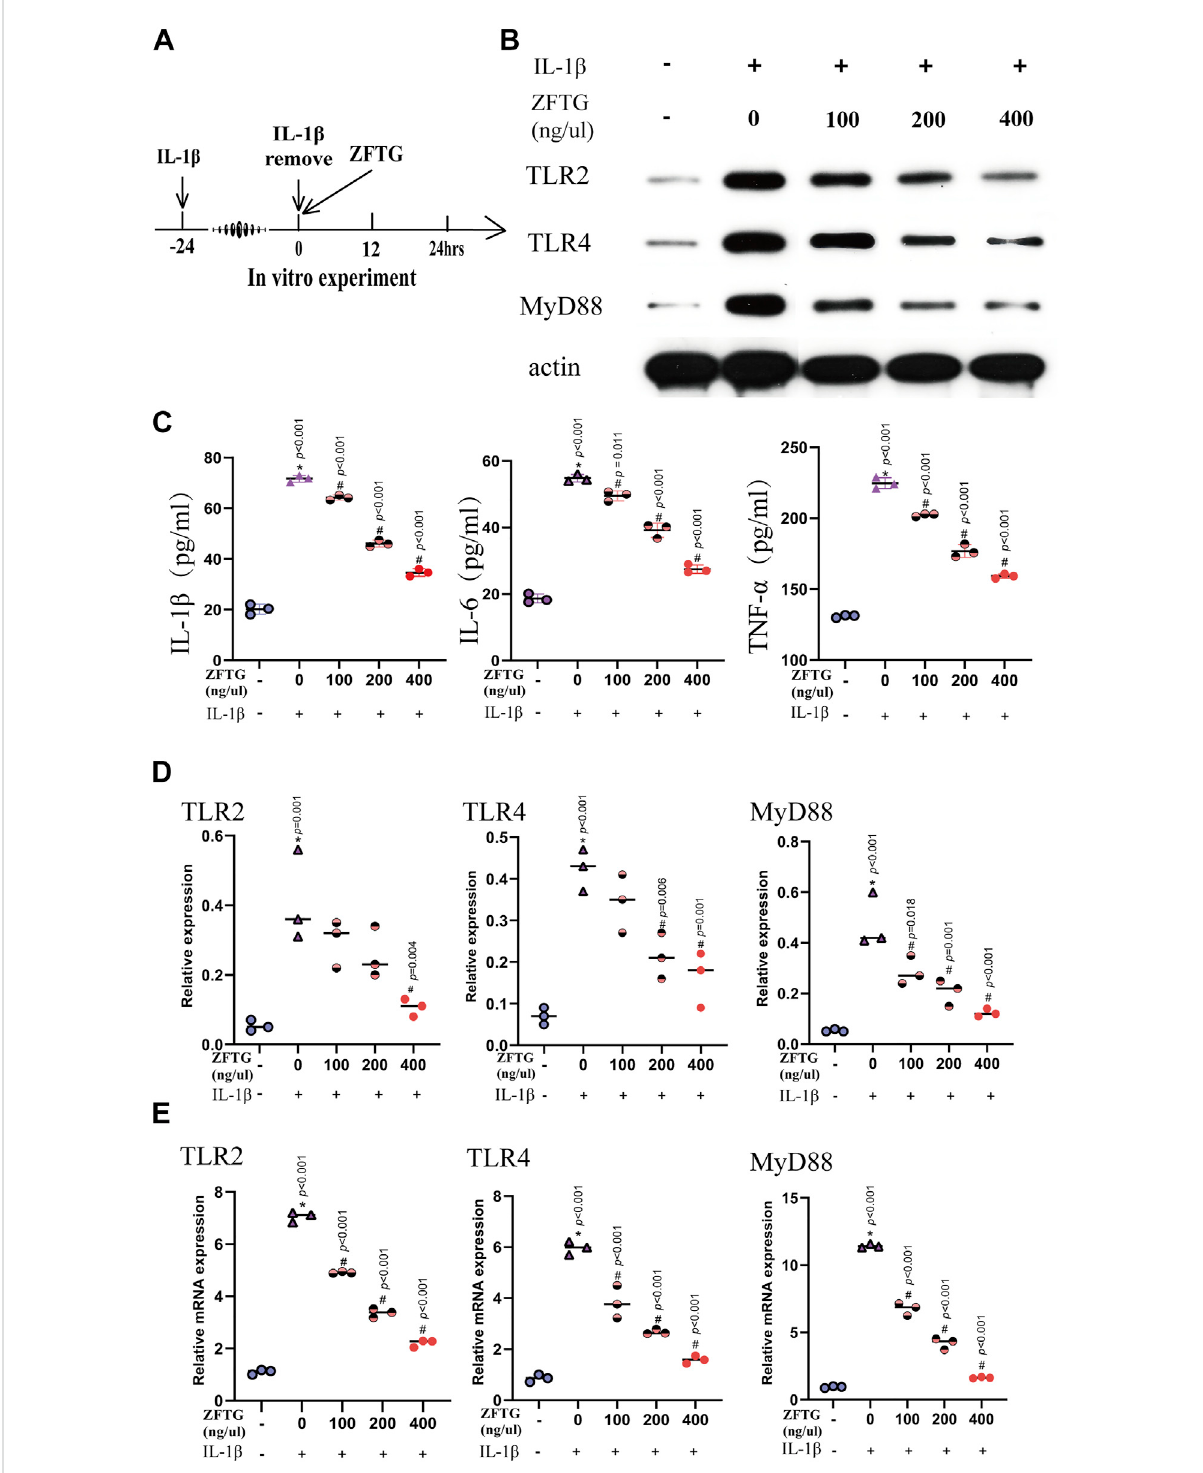
FIGURE 9 ZFTG inhibits the TLR2/TLR4/MyD88 signaling pathway in alleviating in fl ammatory damage of chondrocytes. (A) Experiment design for cells. Primary chondrocytes were stimulated with IL-1 β (10 ng/ml) for 24 h s (M IL-1 β ) before removing IL-1 β and adding ZFTG (0, 100, 200, and 400 ng/ μ l) treatment. (B,D) WesternblotanalysisofTLR2,TLR4,andMyD88proteinexpressionwithactinservingasaproteinloadingcontrol. (C) IL-1 β ,IL-6,and TNF- α levels were measured by the ELISA kit according to the manufacturer ’ s instructions. (E) qRT-PCR analysis of TLR2, TLR4, and MyD88 mRNA expression. One-way analysis of variance was used for comparing the protein and gene expression. The data are presented as the mean ± SD. * p < 0.05, vs. BC group; # p < 0.05, vs. MC group. Speci fi c p -values for each pair of comparisons are